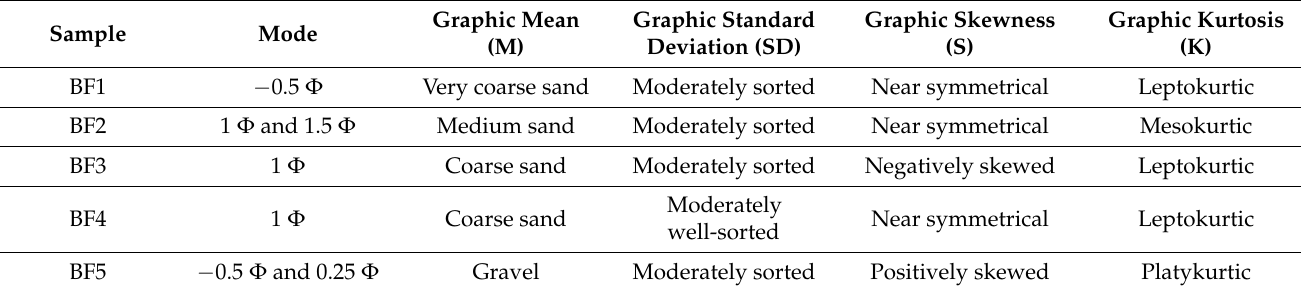
Figure 7. Widely used Udden-Wentworth grain size scale (modified from [38]). Grain size for sediments sample from Batu Ferringhi ranging from − 2.5 Φ (pebble) to 4 Φ (very fine sand). Table 1. Summary on analysis of the five sediment samples’ frequency curves in Batu Ferringhi, representing natural coastal landform sediments.